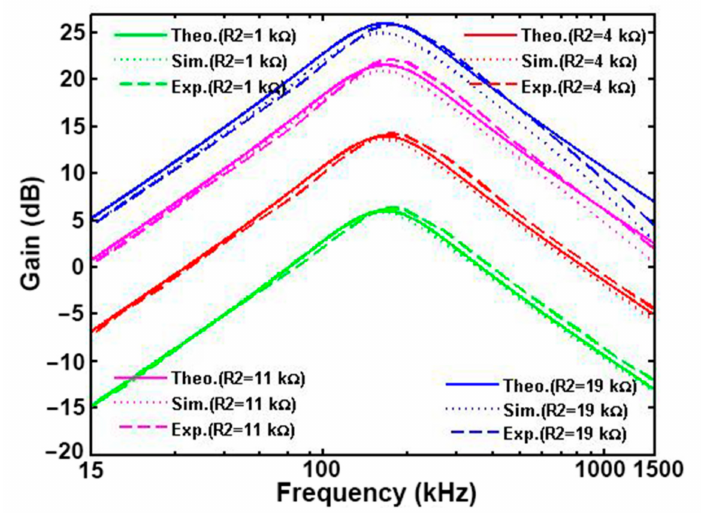
Figure 7. The theoretical, simulated and measured NBPF responses at the voltage output of V BP3 when R 2 was